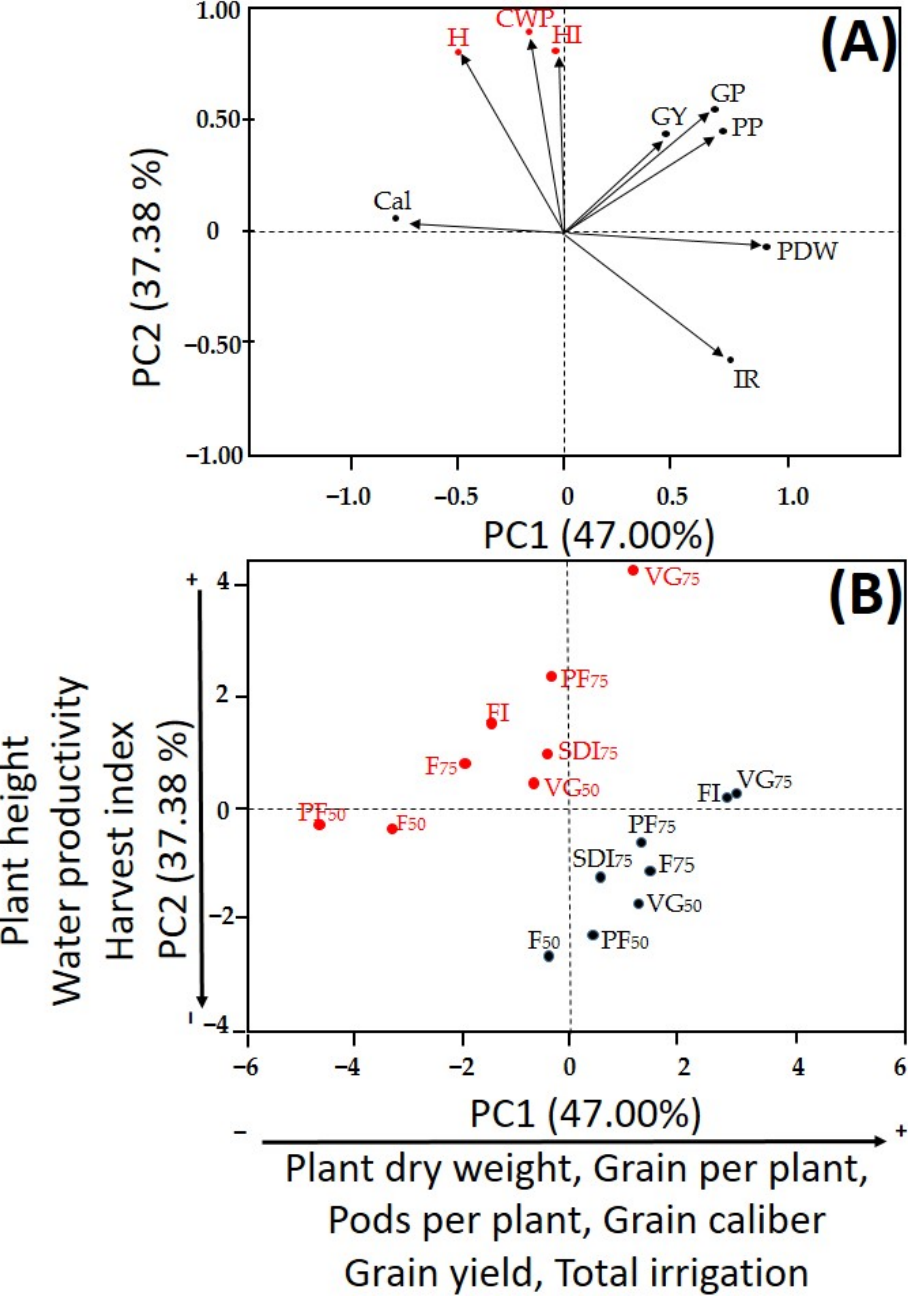
Figure 7. ( A ) Variable distribution and ( B ) irrigation treatments distribution across the two principal components. Vegetative growth (VG), flowering (F), and pod-filling (PF) stages. RDI = regulated deficit irrigation. FI = full irrigation application of 100% ETc during VG, F, and PF. SDI 75 = sustained deficit irrigation applying 75% of ETc during VG, F, and PF. VG 50 = RDI applying irrigation equivalent to 50% of ETc in VG. VG 75 = RDI applying irrigation equivalent to 75% of ETc in VG. F 50 = RDI applying irrigation equivalent to 50% of ETc in F. F 75 = RDI applying irrigation equivalent to 75% of ETc in F. PF 50 = RDI applying irrigation equivalent to 50% of ETc in PF. PF 75 = RDI applying irrigation equivalent to 50% of ETc in PF.